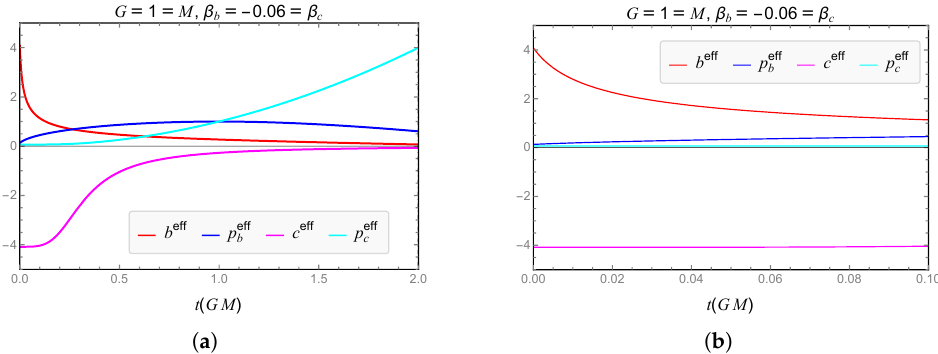
Figure 15. Solutions of the EoM of GUP model 1. ( a ) Solutions to the effective equations of motion for model 1 as a function of the Schwarzschild time t . ( b ) Close up of the left figure close to t = 0. Note that none of the variables diverge or vanish in the interior, and everywhere in the interior b , p b , p c > 0 while c <